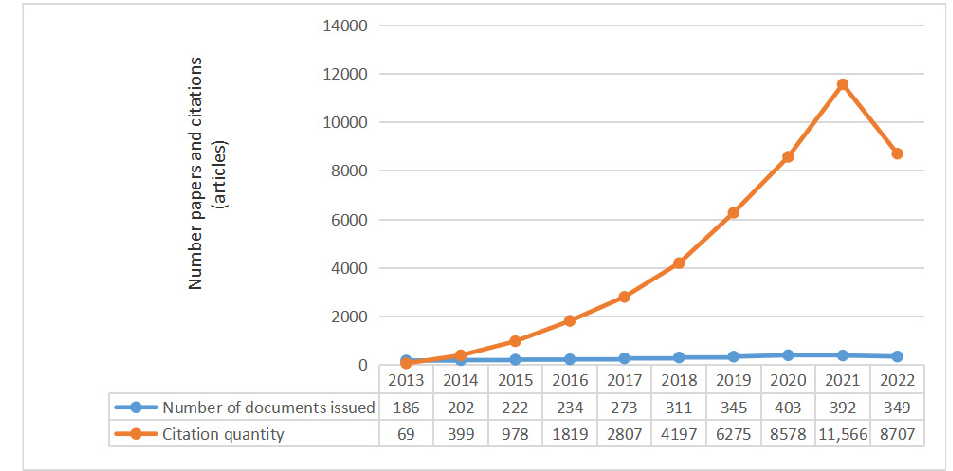
Figure 11. Trends in publications and citations in rural human settlements research.